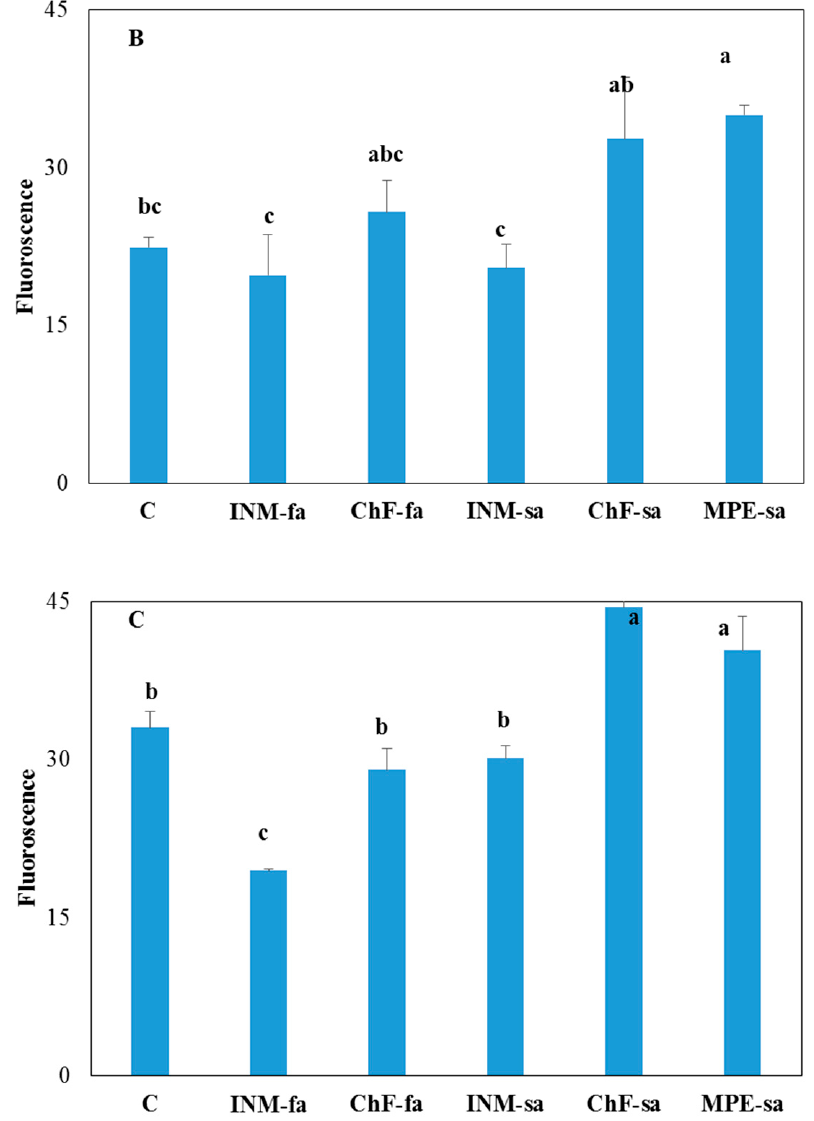
Figure 3. Effect of fertilization through different (root/foliar) application methods on chlorophyll fluorescence value of Origanum microphyllum at: ( A ) vegetative; ( B ) early flowering; ( C ) full flowering stage. C: control (water); INM: integrated nutrient management (INM) by foliar (INM-fa) or soil application (INM-sa); ChF: conventional fertilization by foliar (ChF-fa) or soil application (ChF-sa); MPE-sa: mixture of plant extracts as biostimulant by soil application. Values represent the mean of three replicates ± SEM. Within each plot different letters indicate significant differences.